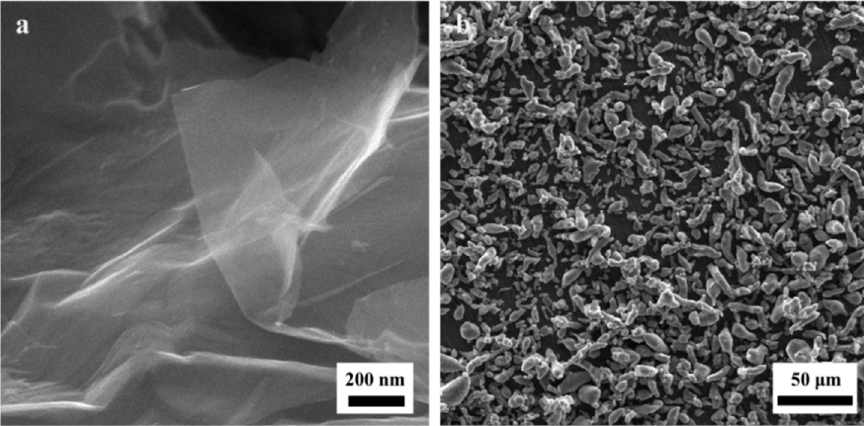
Figure 1. SEM images of ( a ) pure graphene nanosheets and ( b ) aluminum powders.